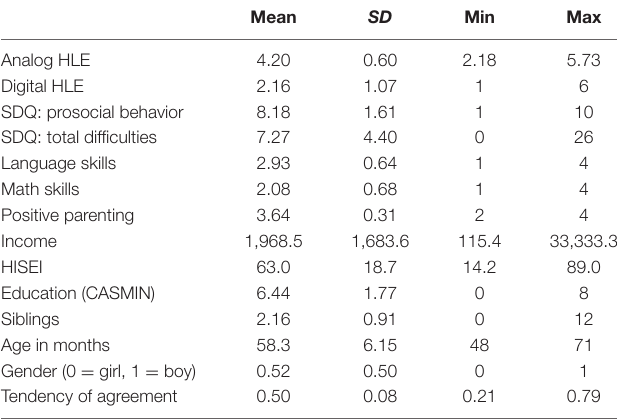
TABLE 2 | Descriptive statistics for the preschool age